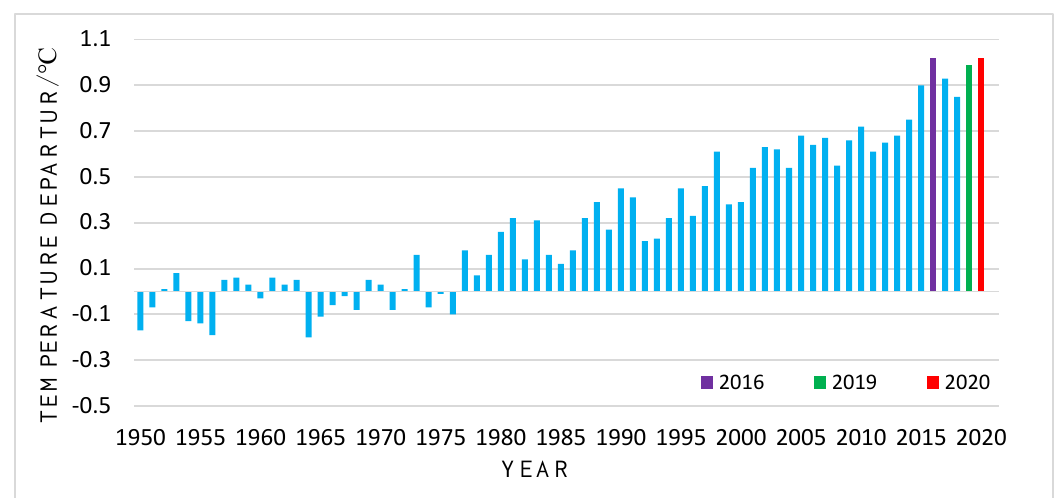
Figure 1. Histogram of global temperature anomalies (based on 1951 – 1980) from 1950 to 2020.